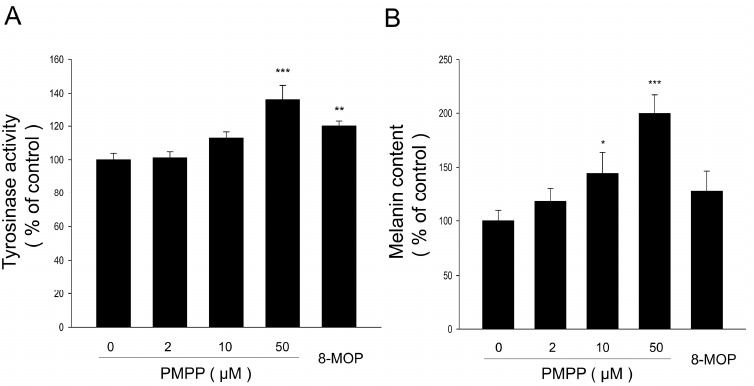
Figure 3. Concentration-dependent effect of PMPP on tyrosinase activity ( A ) and cellular melanin synthesis ( B ) in B16 melanoma cells. Cells were treated with 0.1% DMSO as a vehicle or with PMPP at 2, 10, and 50 μ M and 50 μ M 8-MOP as a positive control. The cells were then analyzed by tyrosinase activity assay ( A ). The data of melanin content is shown ( B ). Each percentage value for treated cells is reported relative to that of 0.1% DMSO cells. The results have been shown as the means ± SD; n = 3, * p <0.05, ** p <0.01, *** p <0.001 compared with 0.1% DMSO cells.